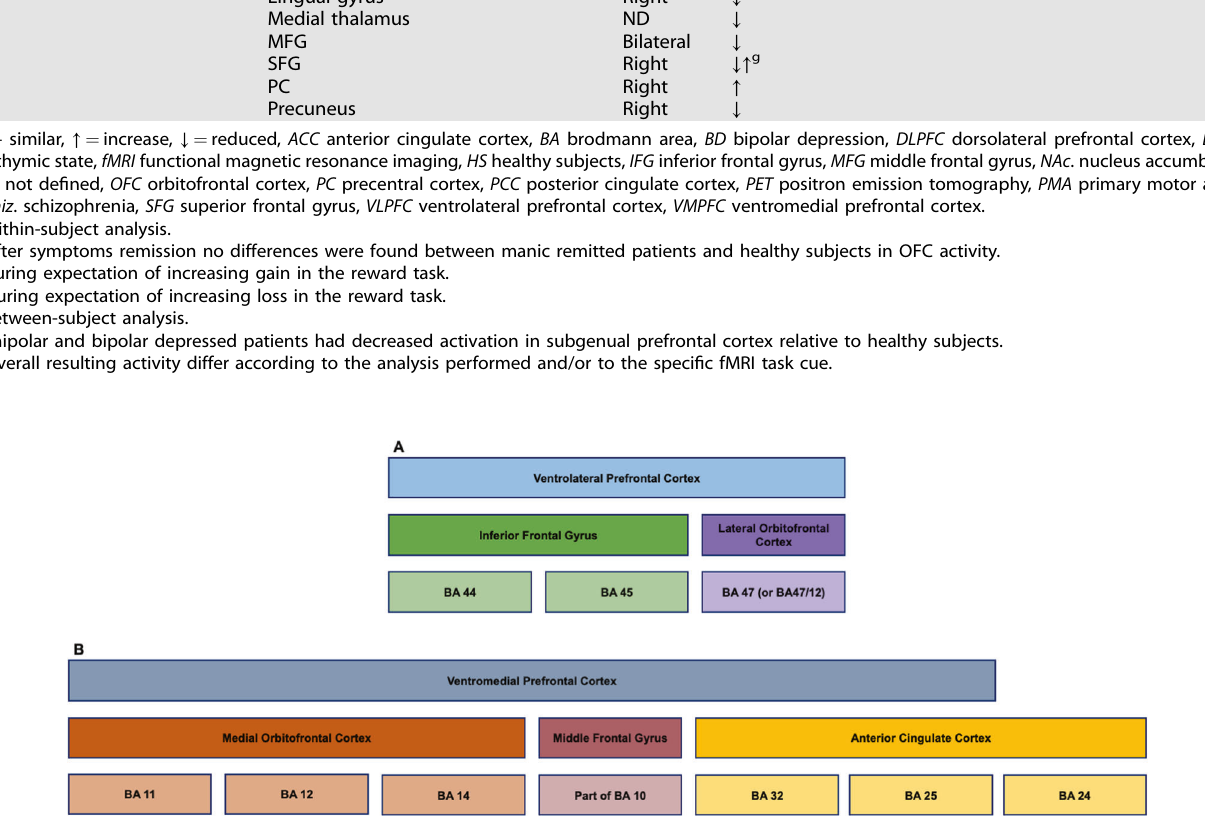
Fig. 1 Neuroanatomy of ventrolateral and ventromedial prefrontal cortices. While there is variability in the nomenclature and in the organization of ventrolateral ( A ) and ventromedial prefrontal cortices ( B ), this diagram represents previously suggested models [36, 40 – 45] for the neuroanatomy of these structures, focusing on regions and areas that are critical for interpretation of the functional neuroanatomy of